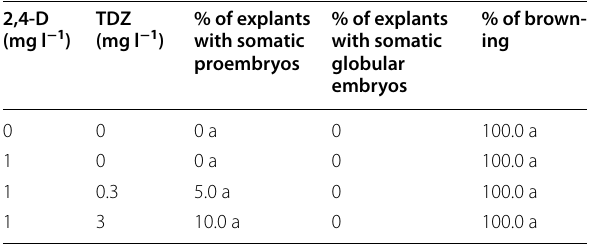
Means within a column followed by the same letter are not significantly different according Duncan’s multiple range test at p